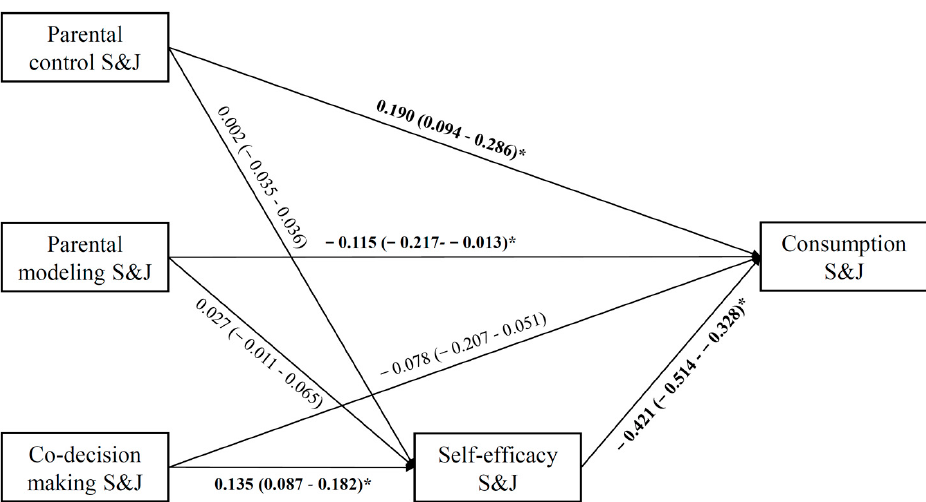
Figure 3. Path model of adolescents’ sugar-sweetened beverage and junk food (S&J) consumption, adjusted for age, gender, adolescents’ educational level, parental education level, monthly household income, perceived health status, perceived weight status, perceived peer influence, BMI, and physical activity. β -coefficient and 95% CI are in parentheses. Significant results are bolded. * p < 0.05.